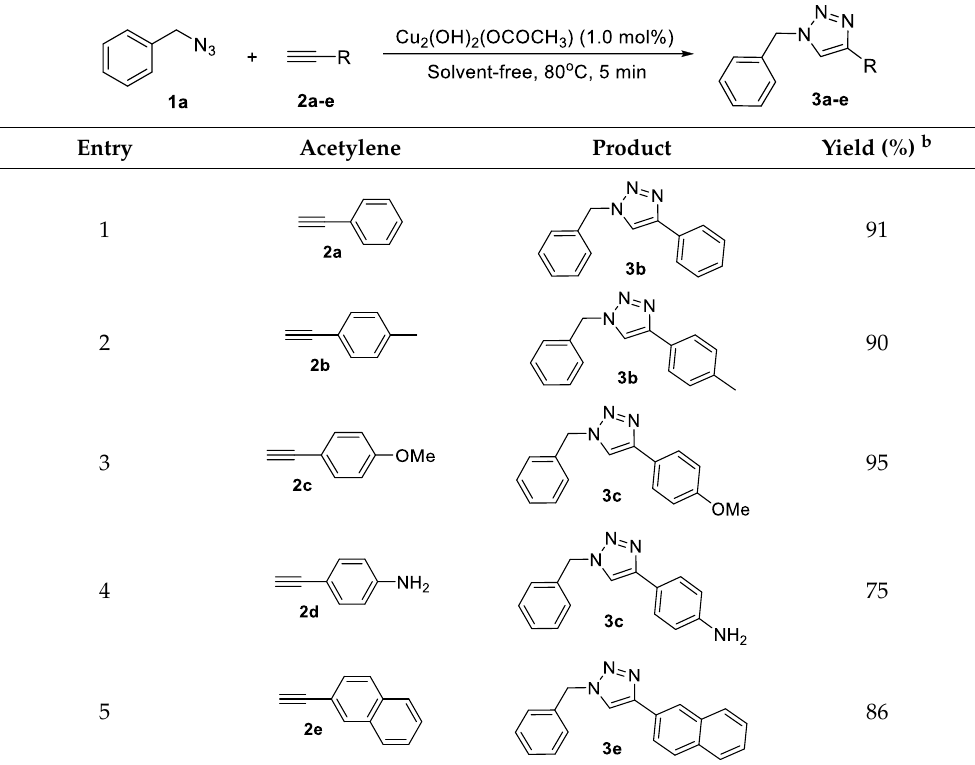
Table 4. Synthesis of Cu 2 (OH) 2 (OCOCH 3 )-catalyzed 1,4-disubstituted-1,2,3-triazoles a .